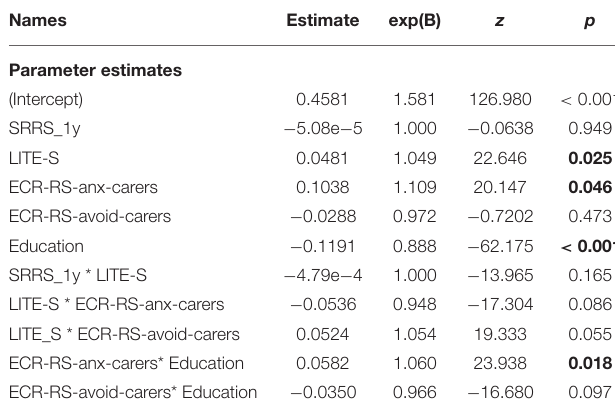
TABLE 2 | Results of the binary multinomial logistic regression model: carers’ attachment anxiety/avoidance and stressful life events. Names